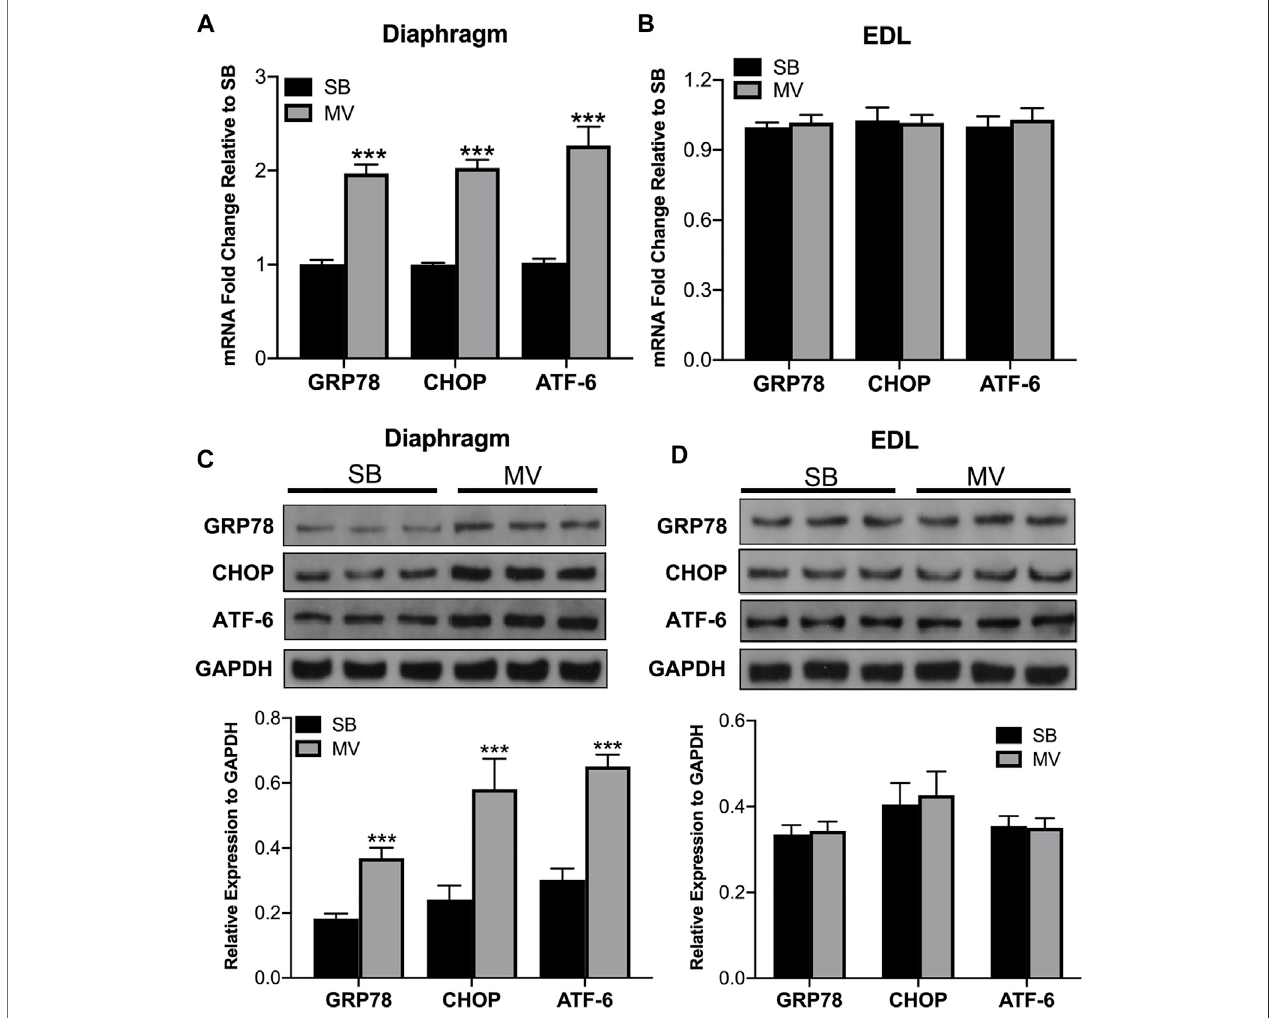
FIGURE2| ERstressisinducedbyMVinthediaphragm. ERstresswasmeasured byquantifyingGRP78CHOPand ATF-6expression. mRNAtranscript levelsof ER stress-related genes in the diaphragm (A) but not the EDL (B) were increased in the MV group compared with the SB group. In addition, immunoblotting revealed markedincreasesinERstress-relatedproteinexpressioninthediaphragm (C) butnottheEDL (D) afterMVcomparedtoafterSB.*** p < 0.001versustheSBgroup.The experiments were repeated three times for each sample (unpaired t- test, n = 6 per group). MV = mechanical ventilation; SB = spontaneous breathing; EDL = extensor digitorum